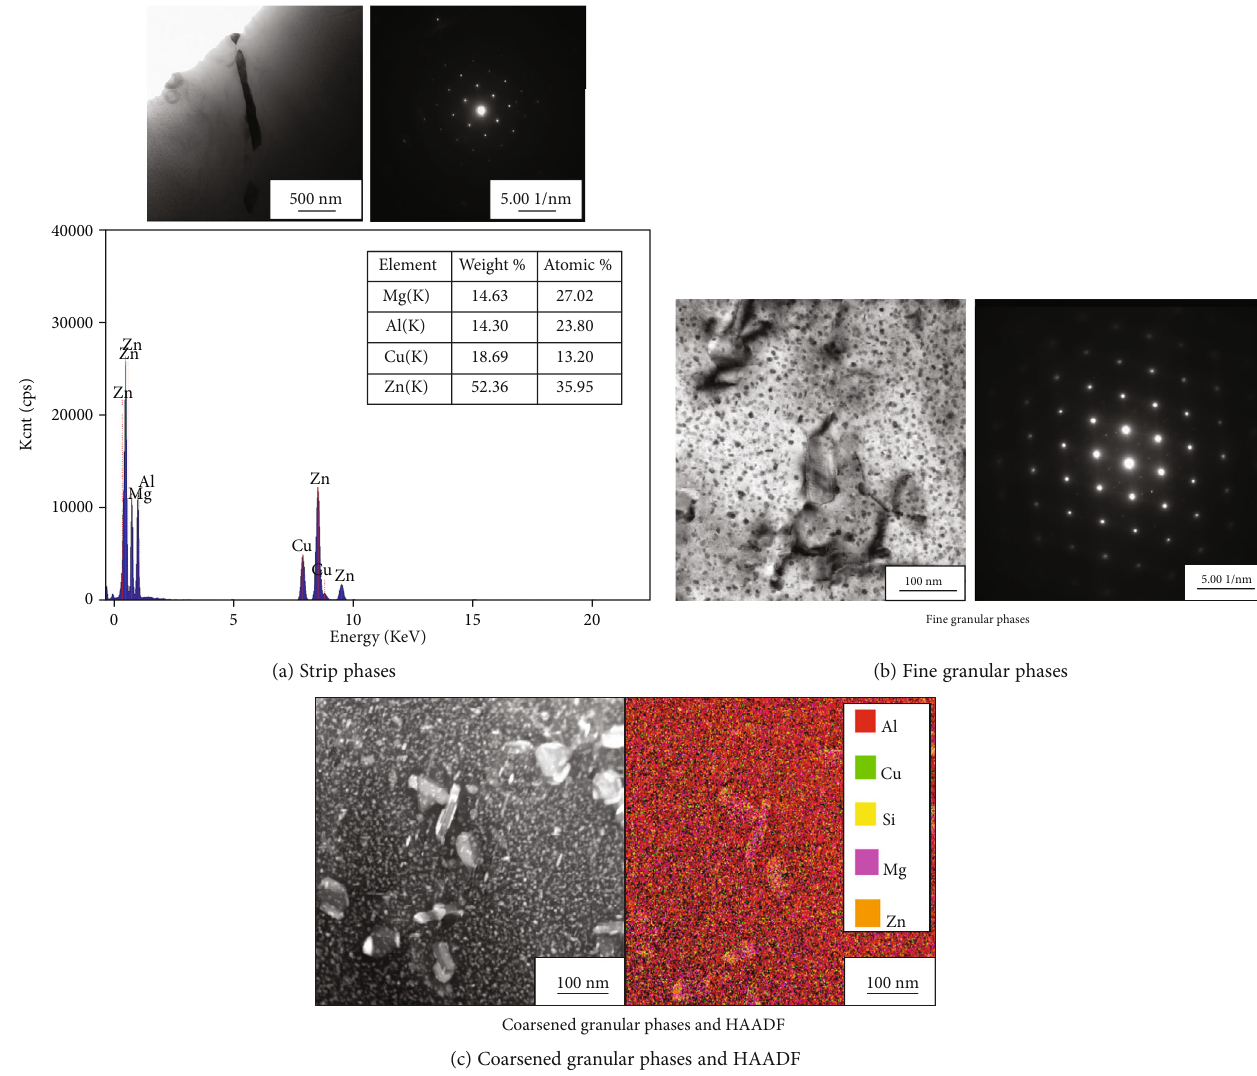
Figure 7: TEM photos of the 7075